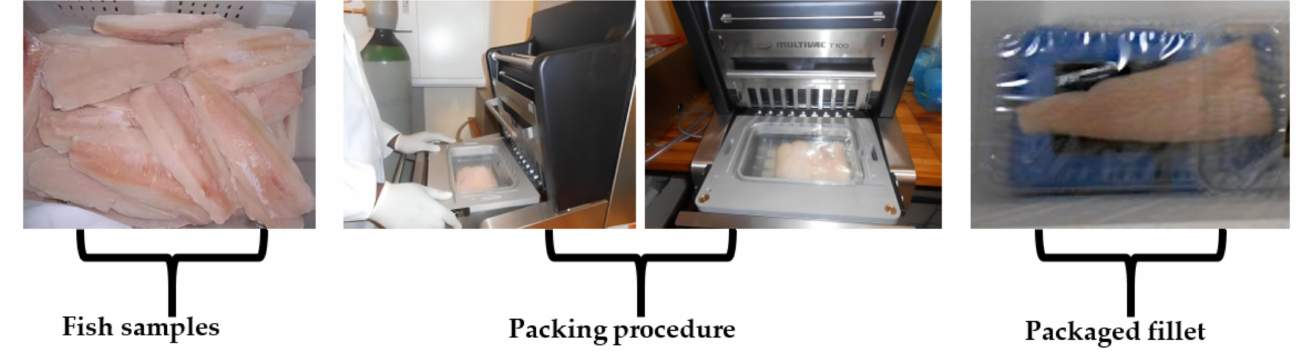
Figure 1. An illustration of the fish fillet packaging